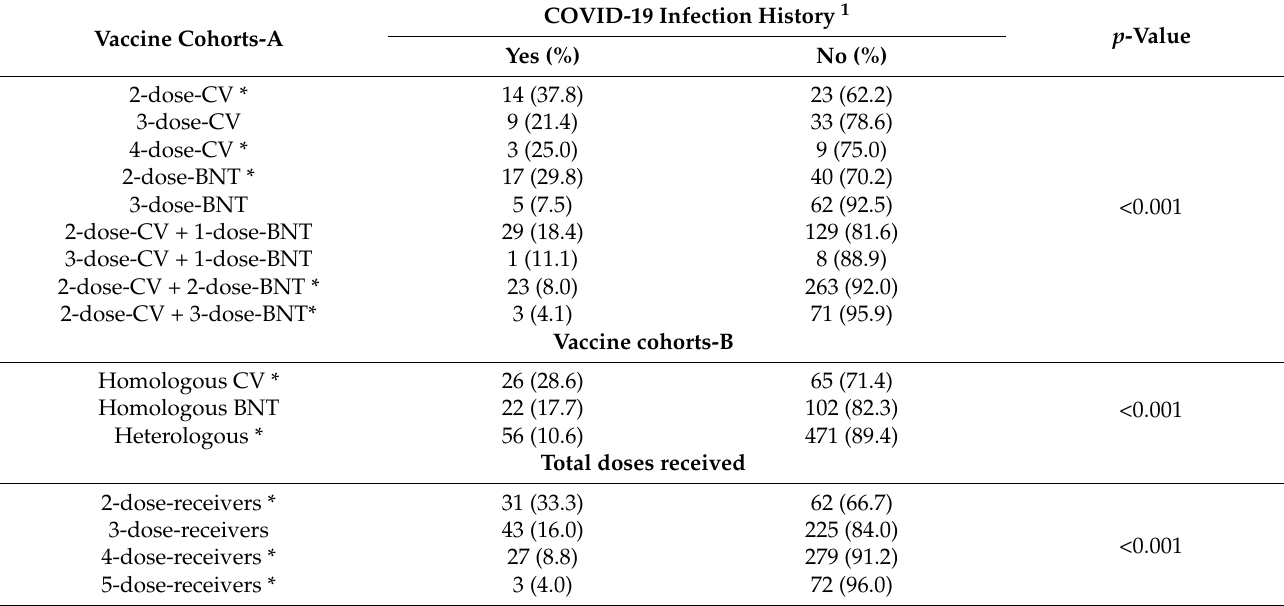
Table 2. Comparison of COVID-19 infection history by vaccine schedules and number of